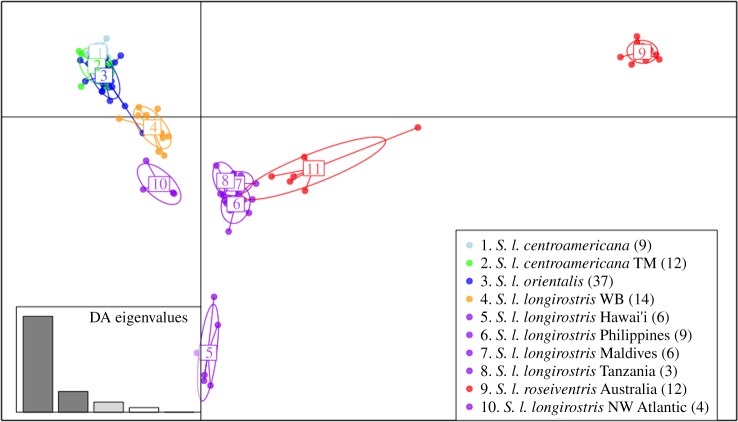
Genomic variation across individuals and populations of spinner dolphins. Scatter plot of individuals based on the first two eigenvalues (created from optimum nine principal components) of the DAPC. Ellipses represent 67% of the variation for each population. Inset shows the amount of variation represented by the DA eigenvalues. Points and ellipses are coloured by subspecies (red = S. l. roseiventris; purple = S. l. longirostris; dark blue = S. l. orientalis; light blue =S. l. centroamericana) and population (orange = whitebelly spinner; light green = Tres Marias Island spinner).